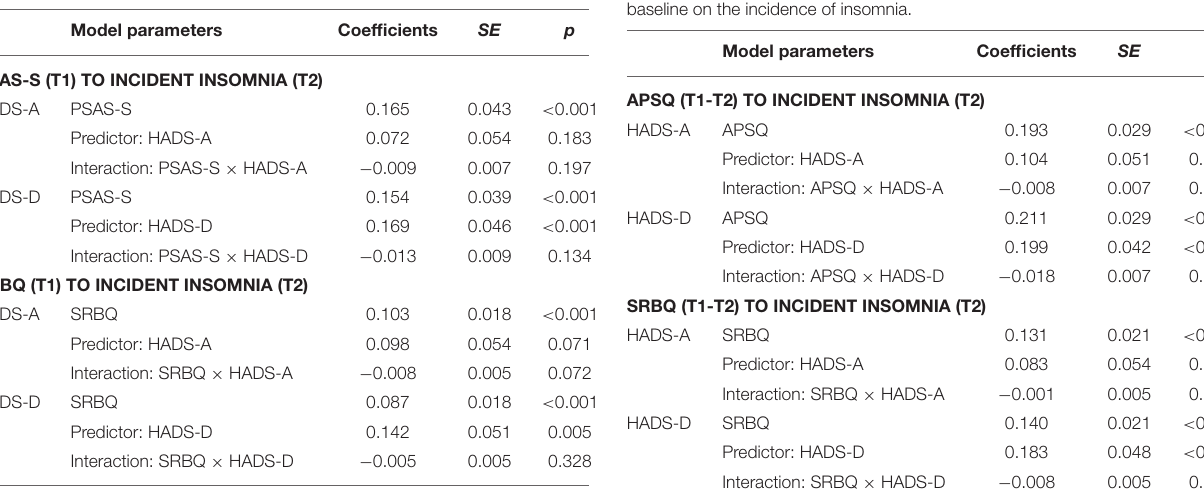
TABLE 4 | Results from the moderation models examining the effects of two cognitive processes (PSAS-S and SRBQ) and anxiety and depressive symptoms (HADS-A and HADS-D) at baseline on the incidence of insomnia.